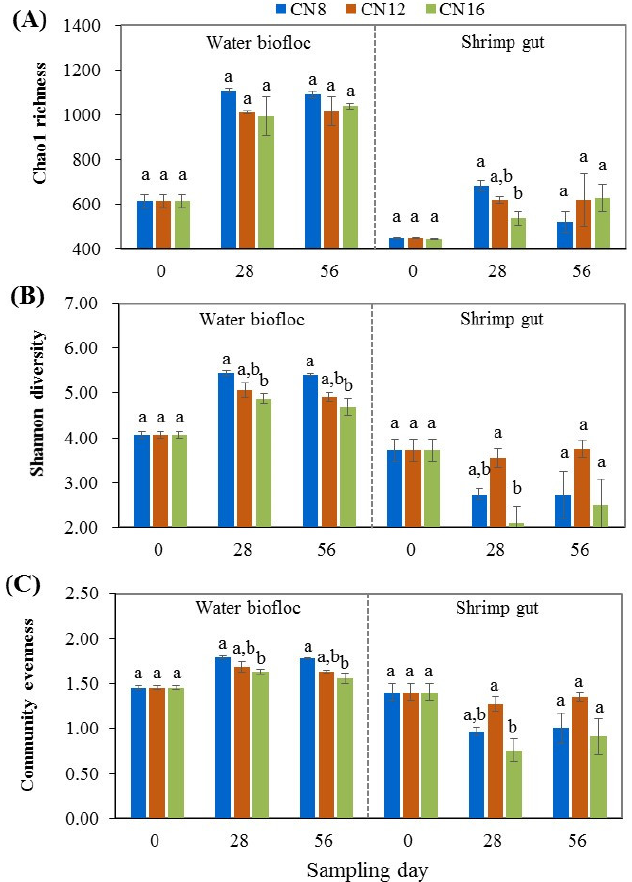
Figure 4. Alpha diversity of the bacterial community in water biofloc and shrimp gut from biofloc- based tank systems during an 8-week intensive production trial of P. vannamei with three input C/N ratios (means ± S.D., n = 3). Different letters indicate significant difference at the same time point among the three C/N ratio groups.